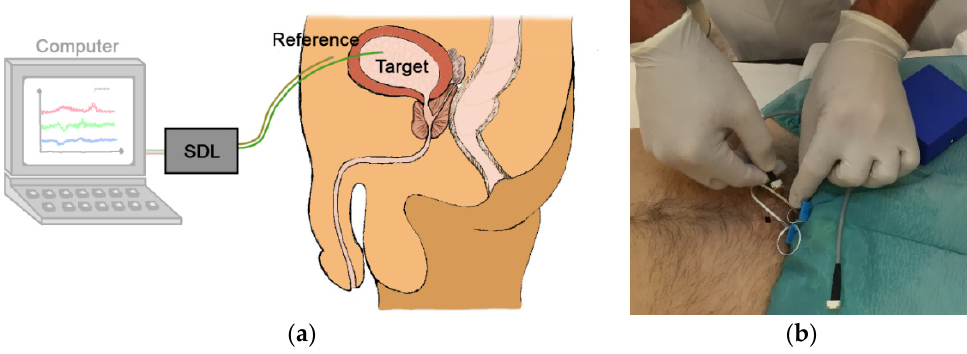
Figure 4. ( a ) The illustration of the suprapubic approach with one target sensor probe in the urinary bladder and a reference sensor probe outside the bladder; ( b ) Suprapubic approach for cystometry, used in a clinical trial on a sample of convenience.